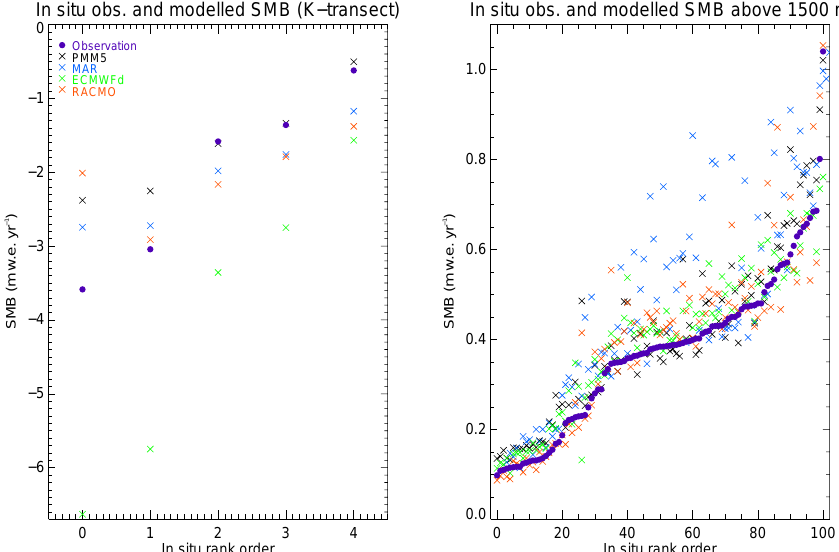
Fig. 10. In situ SMB observations (purple) plotted in increasing SMB (rank) order along horizontal axis with the equivalent model estimated SMB in